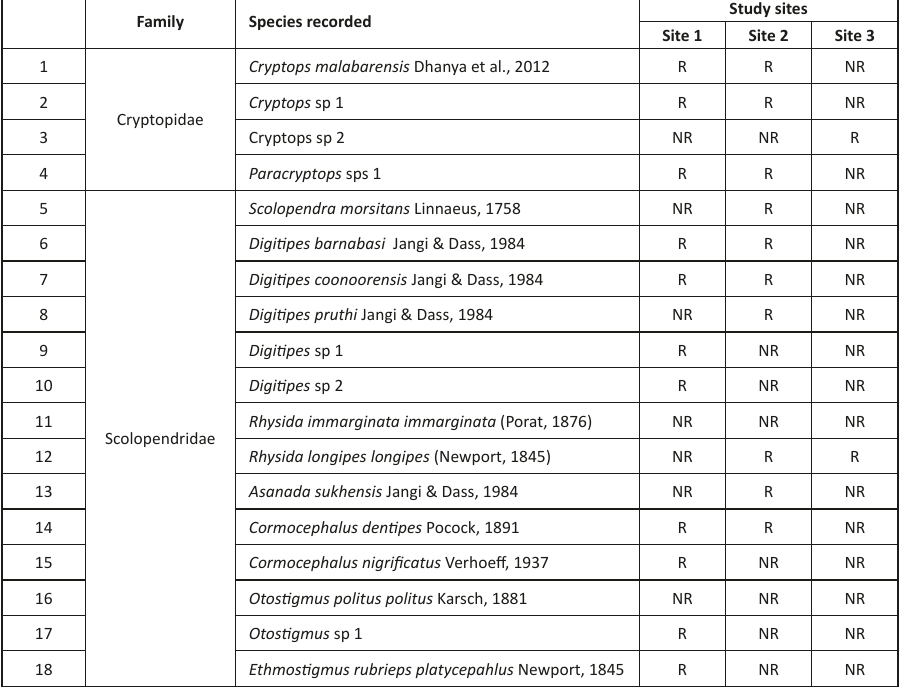
Table 1. Species composition in three